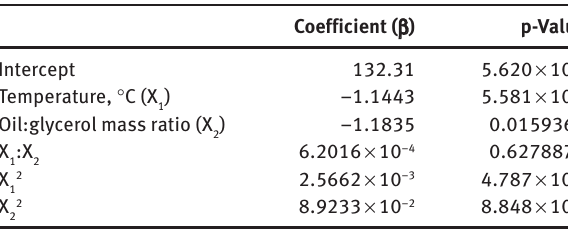
Table 2: Regressional coefficients of response surface methodology.